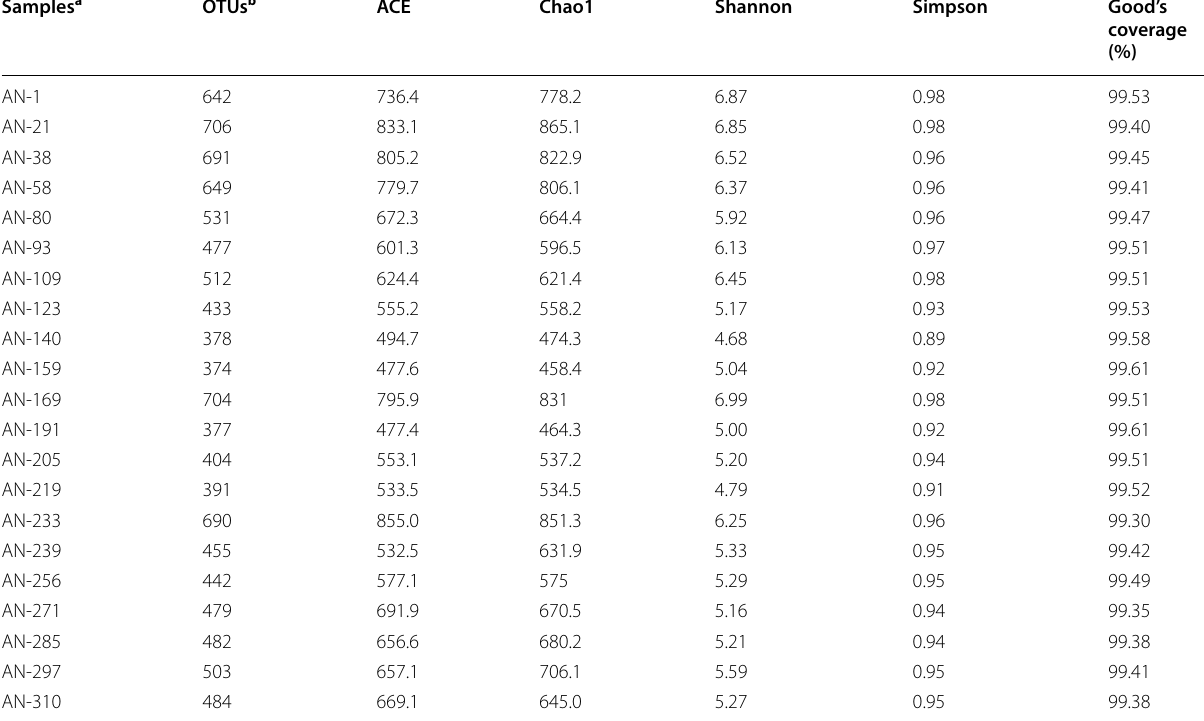
a Numbers following “AN” in this column indicate sampling date (day)